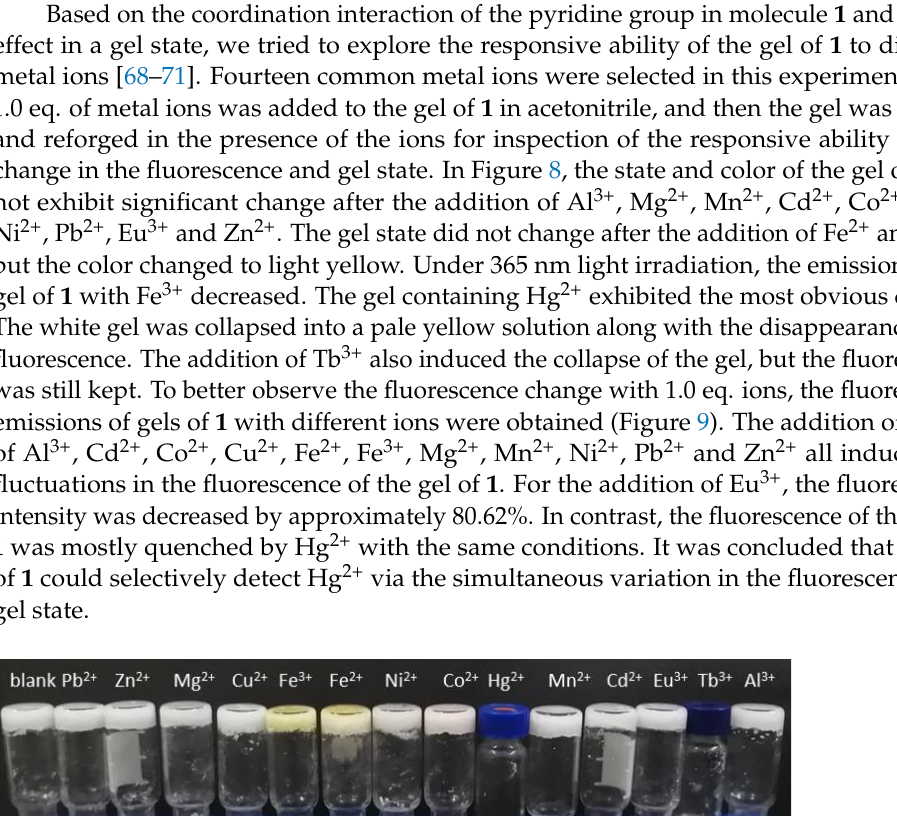
Figure 7. Fluorescence emission spectra of solution (10 −5 M) (a) and gel of 1 (CGC) (b) in acetonitrile with different water content.